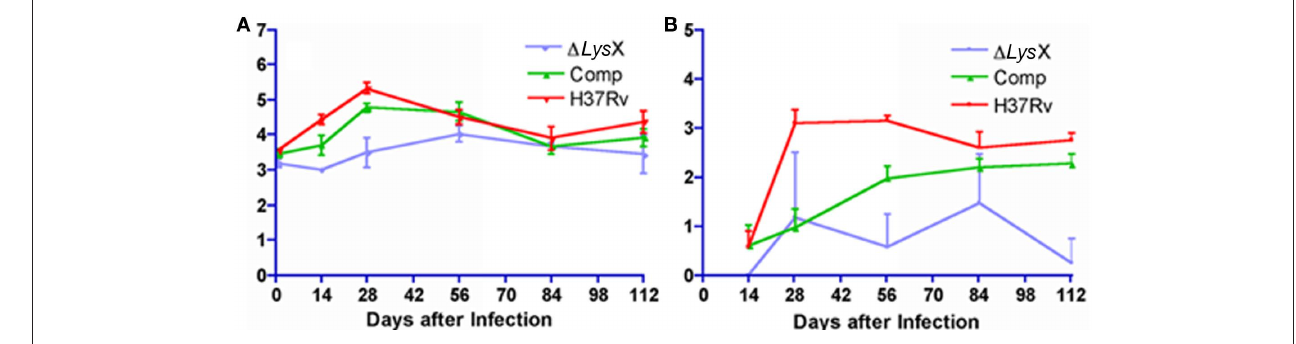
low-dose implantation. Animals were infected via aerosol with M. tuberculosis lys X deletion mutant ( ∆ lys X), lys X tet complement (Comp), and wild-type (H37Rv) strains. Groups of 28 mice were implanted at day 1 with 3.2- ( ∆ lys X), 3.5- (Comp), and 3.6-log (H37Rv) CFU in the